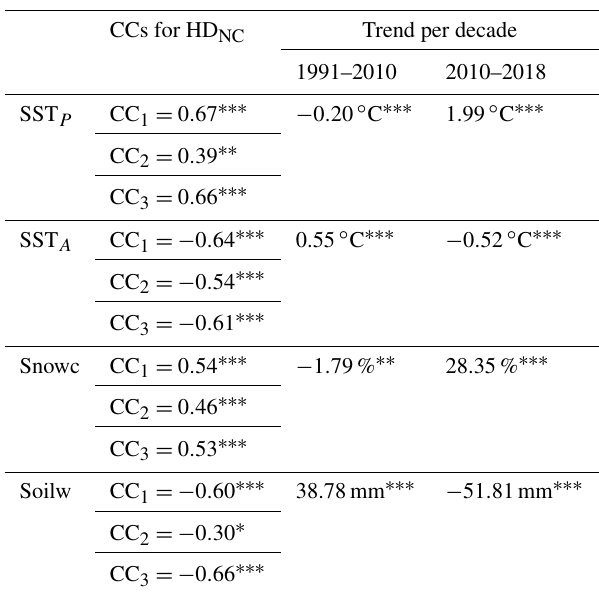
Table 1. Correlation coefficients (CCs) between HD NC and the SST P , SST A , Snowc and Soilw indices after detrending, and the trends of the SST P , SST A , Snowc and Soilw indices for the 1991– 2010 and 2010–2018 periods. CC 1 , CC 2 and CC 3 represent the cor- relation coefficients from 1979 to 2018, 1979 to 2010 and 2010 to 2018, respectively. “ ∗∗∗ ” indicates that the CC was above the 99% confidence level, “ ∗∗ ” indicates that the CC was above the 95% confidence level and “ ∗ ” indicates that the CC was above the 90% confidence